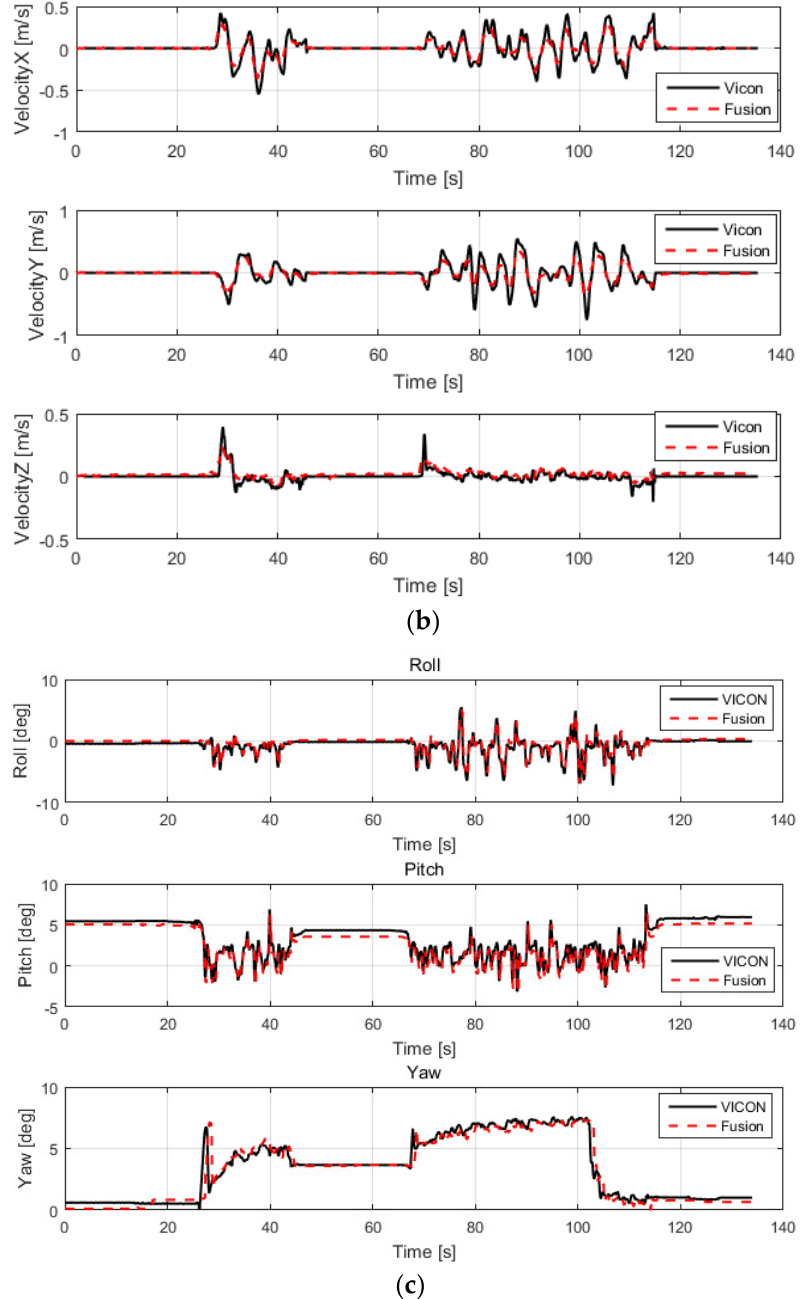
Figure 4. Comparison of the estimated pose and velocity of the unmanned aerial vehicle (UAV) in an indoor environment. ( a ) Contrast between the position estimation of the VICON system and that of the fusion-based system; ( b ) contrast between the velocity estimation of the VICON system and that of the fusion-based system; ( c ) contrast between the attitude estimation of the VICON system and that of the fusion-based system. The red line represents the fusion-based system’s velocity estimation, and the black line represents the ground truth, which was provided by the VICON system.